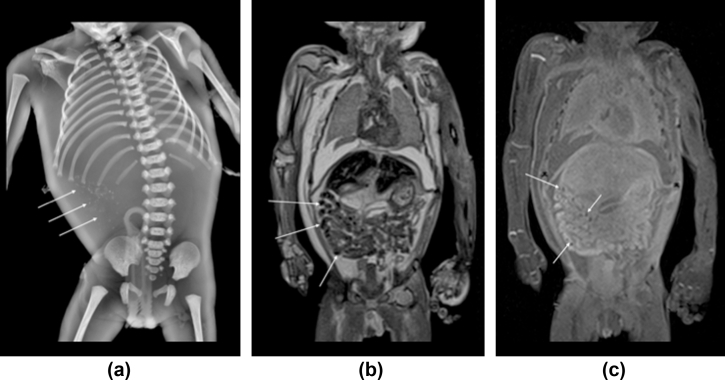
A 29-week-old stillborn fetus, found to have duodenal atresia and hypoplastic aortic arch at autopsy. The frontal PMSS (a) demonstrates multiple linear calcific densities in the right hemiabdomen. The subsequent post-mortem MRI images, presented in coronal section on the (b) T2-and (c) T1-weighted sequences demonstrate low signal intraluminal material (arrows), consistent with calcified meconium.